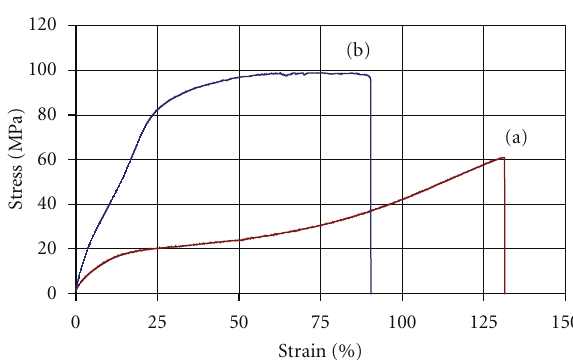
Figure 2: Tensile stress-strain curves of (a) Neat UHMWPE (b)